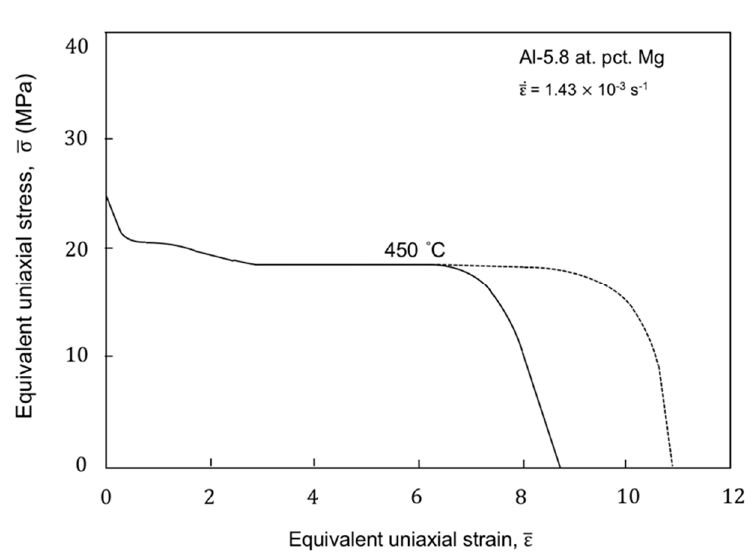
Figure 3. Softening observed in Al-5.8 at % Mg deformed to large strains in the solute drag regime. the solid curve represents the behavior of an L/d = 10 specimen tested using the Rheometrics Spectrometer. The dashed line represents the increased ductility of the L/d = 5 specimens tested on the Stanford torsion machine [6].